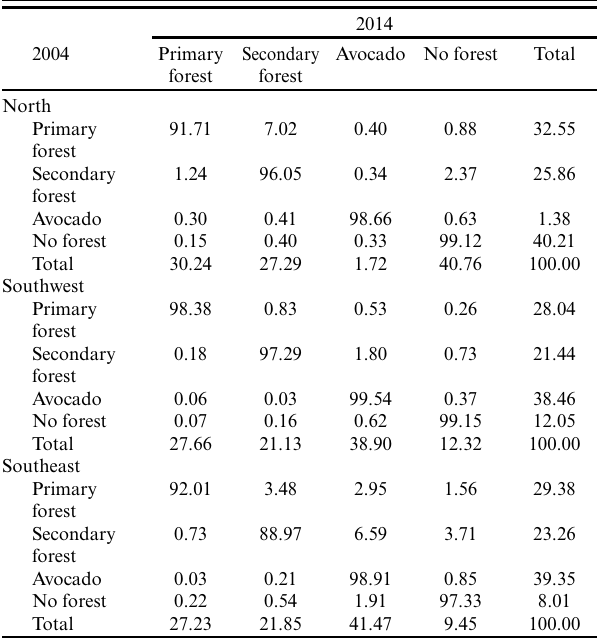
Table 1 . Matrix of percentages of forest-cover changes per subregion (2004-2014).